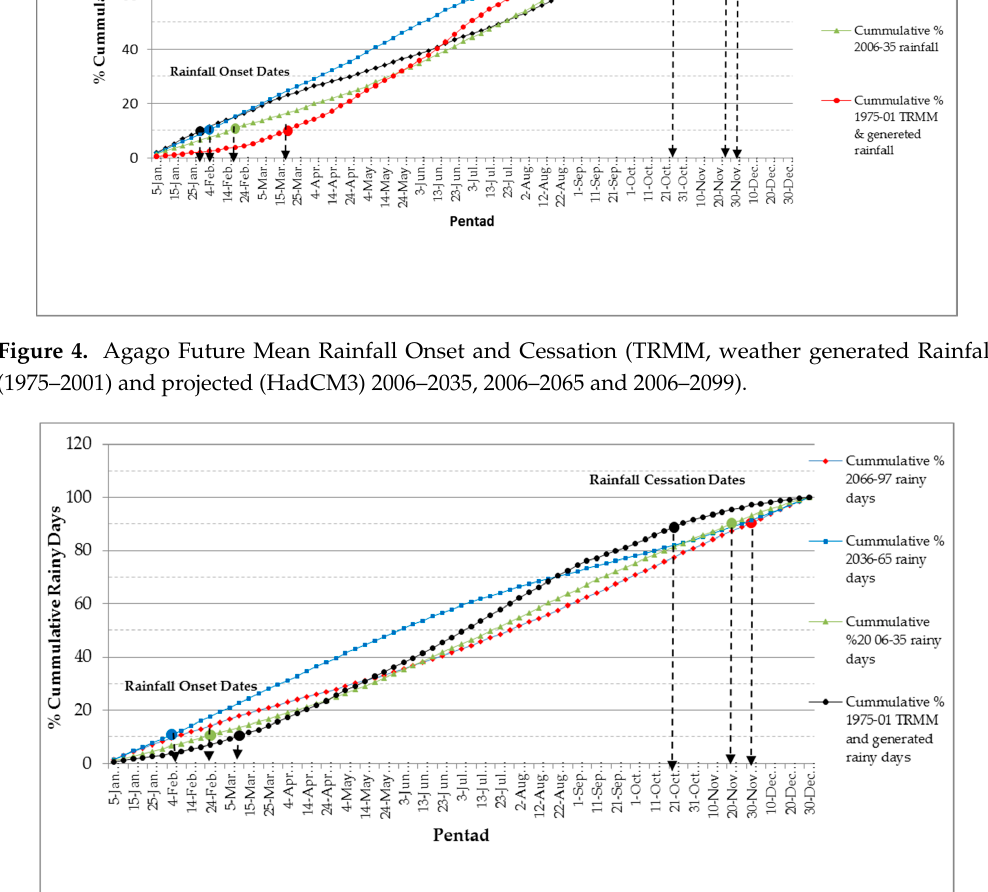
Figure 5. Agago Future Mean Rainfall Onset and Cessation for Rainy Days (TRMM Rainfall (1975-2001) and projected (HadCM3) 2006–2035, 2006–2065 and